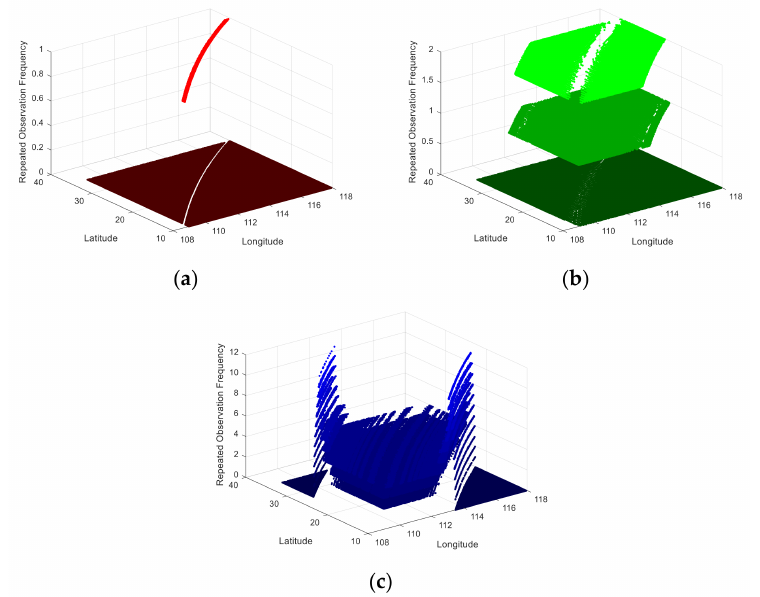
Figure 8. A diagram of the frequency of repeated observation. ( a ) Push broom; ( b ) Whisk broom; ( c ) Rotary